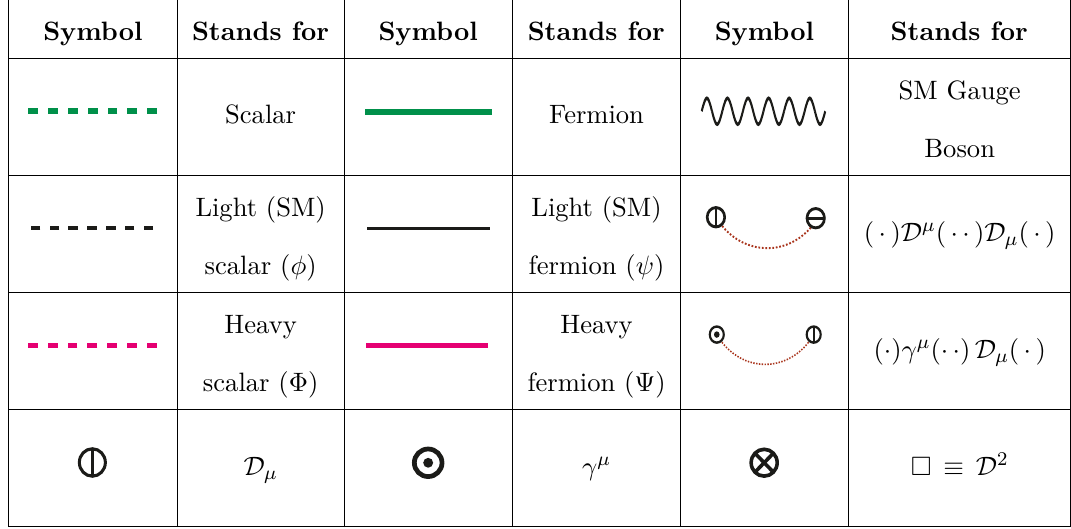
Table 1 . The symbols used throughout the paper and their